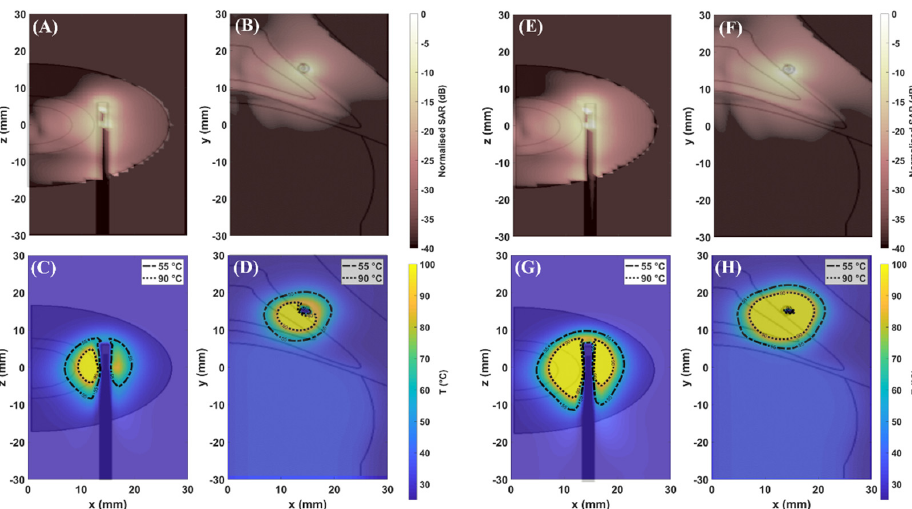
Figure 3. Maps of SAR: ( A , E ) (xy–plane); ( B , F ) (xz–plane) and maps of temperature: ( C , G ) (xy– plane); ( D , H ) (xz–plane), obtained in simplified model at 30 W and 60 W at 5.8 GHz. The applicator is aligned at the interface between fat and adrenal gland (Figure 1A). The longitudinal axis of the applicator is parallel to the y–axis.